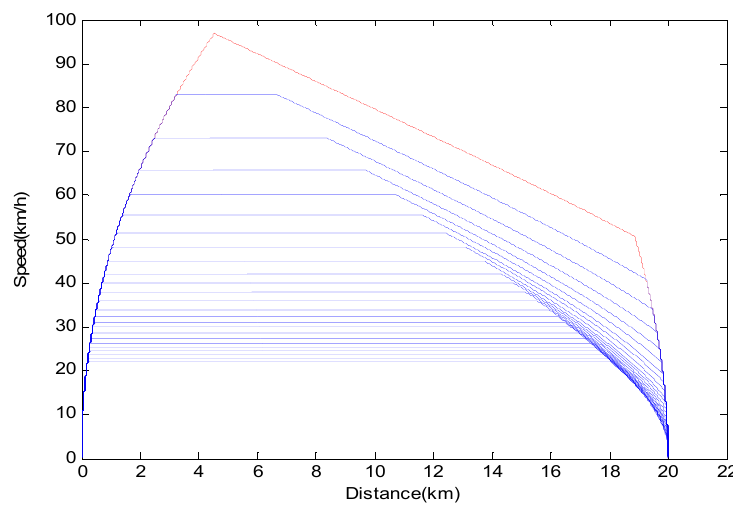
Figure 8. Equidistant speed profiles with various running times.